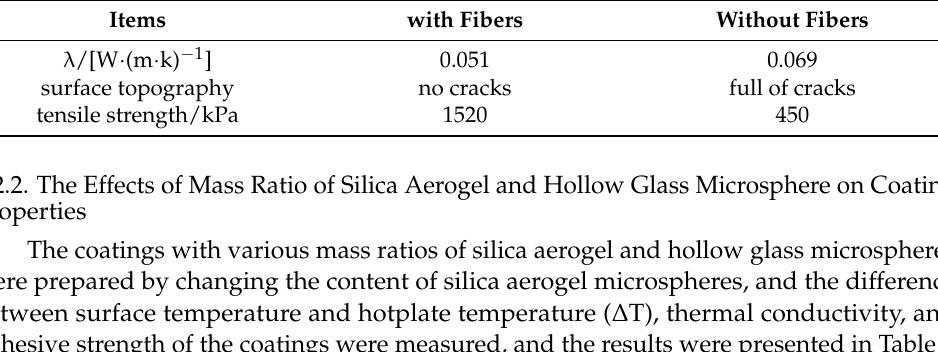
Table 2. Thermal conductivity of the coating with or without fibers. Items with